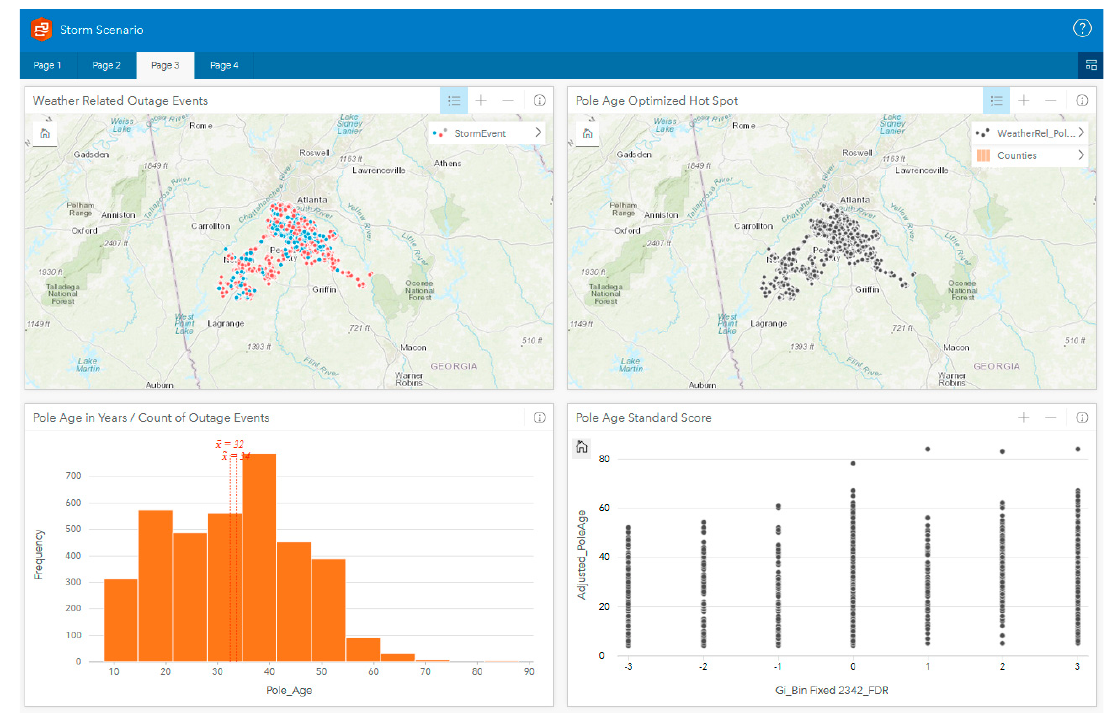
Figure 4. Challenge 1—Storm Scenario Workbook—Page 2.